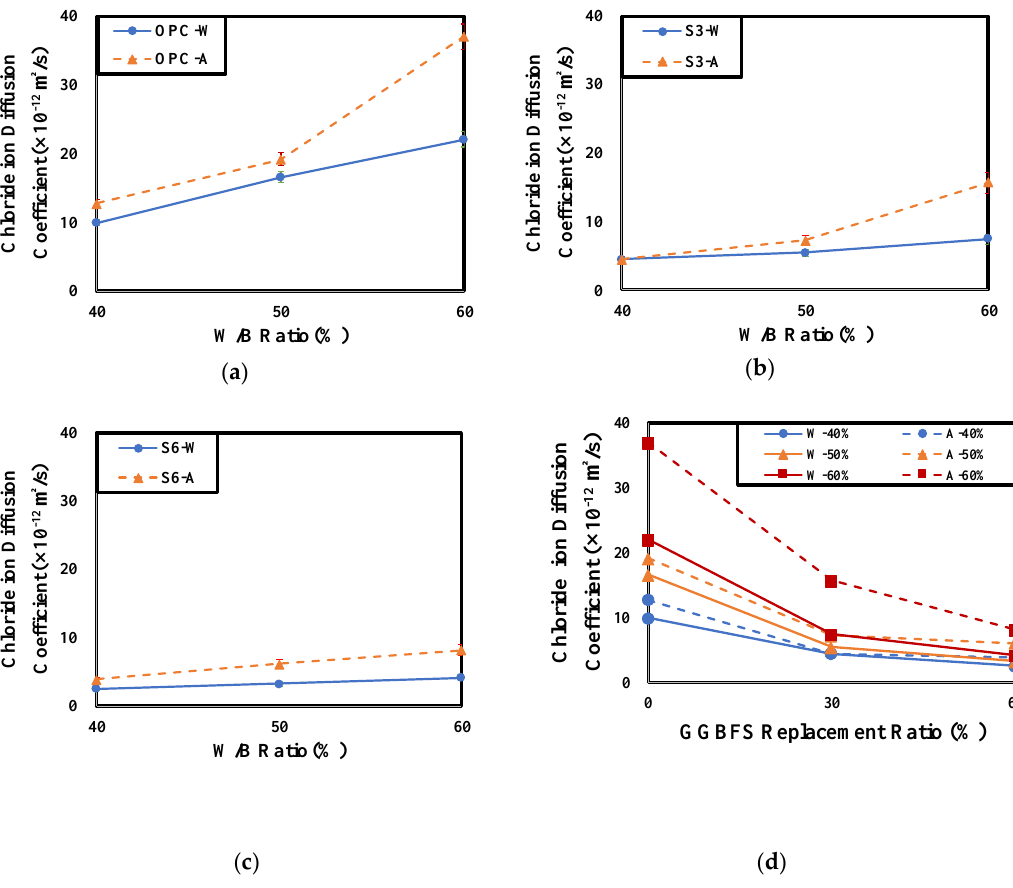
Figure 8. Chloride ion diffusion coefficient of concrete according to curing condition and W/B ratio. ( a ) OPC, ( b ) OPC 70% + GGBFS 30%, ( c ) OPC 40% + GGBFS 60%, ( d ) Chloride ion diffusion coefficient of all specimens according to GGBFS replacement ratio.